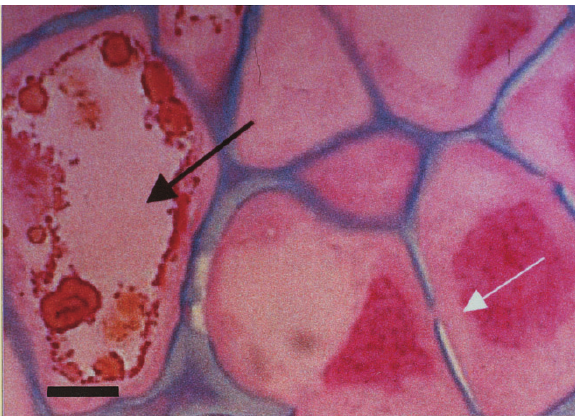
Fig. 6. Knot parenchyma cells with substances of pro- bable phenolic nature (black arrow), and cells with in- terruptions in the cell walls (white arrow). Bar=10 μ m (fuchsin-Astra blue).